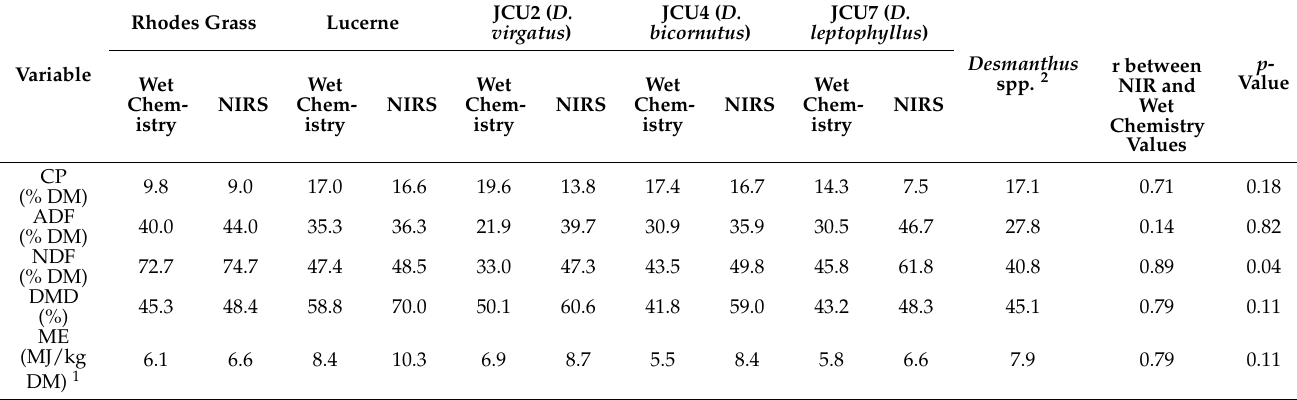
Table 2. Comparative chemical composition of the experimental dietary component determined by wet chemistry and NIRS. Rhodes Grass Variable